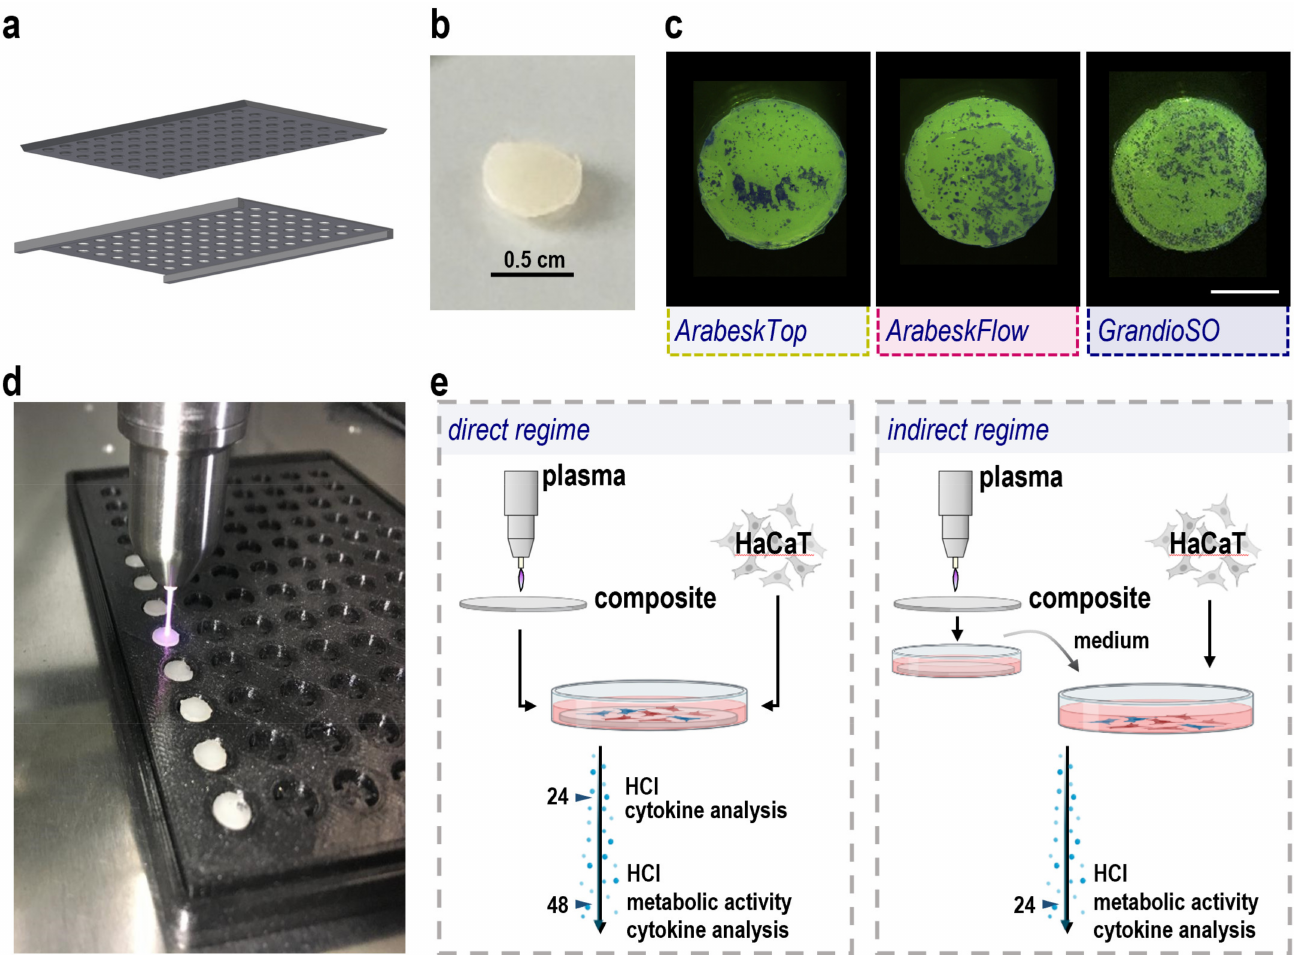
Figure 1. Composite chip manufacturing and treatment. ( a ) rapid prototyping of 3D-printed 96-well schemes for insertion of a defined amount of dental composite material prior to material hardening using a standard dental UV lamp for a predetermined time; ( b ) image of a standardized composite chip generated with the workflow; ( c ) stereo-microscopy of composite chips incubated with human HaCaT keratinocytes for 48 h, fixation of the chips and cells, and staining using crystal violet, providing evidence of cellular material adherent to the chips; ( d ) xyz -stage automated gas plasma treatment of the center of each chip added to a customized 3D-printed vented 96-well holder for the treatment times 30 s, 60 s, and 120 s; ( e ) experimental schemes of ( e ) direct and indirect gas plasma treatment workflows and (24 h, 48 h) incubation times (HCI = high content imaging) (designed using